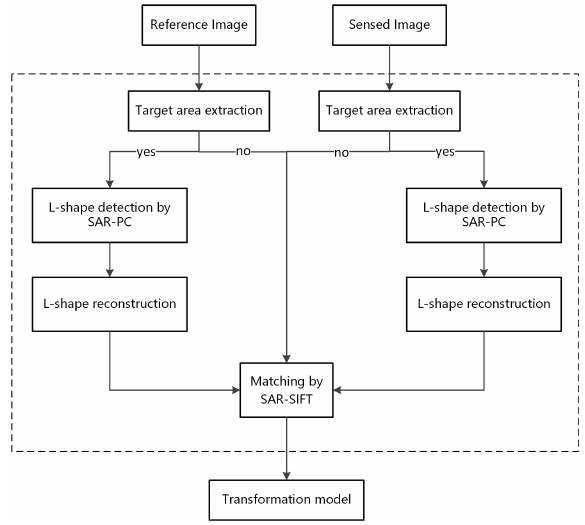
Figure 2. The flowchart of the proposed